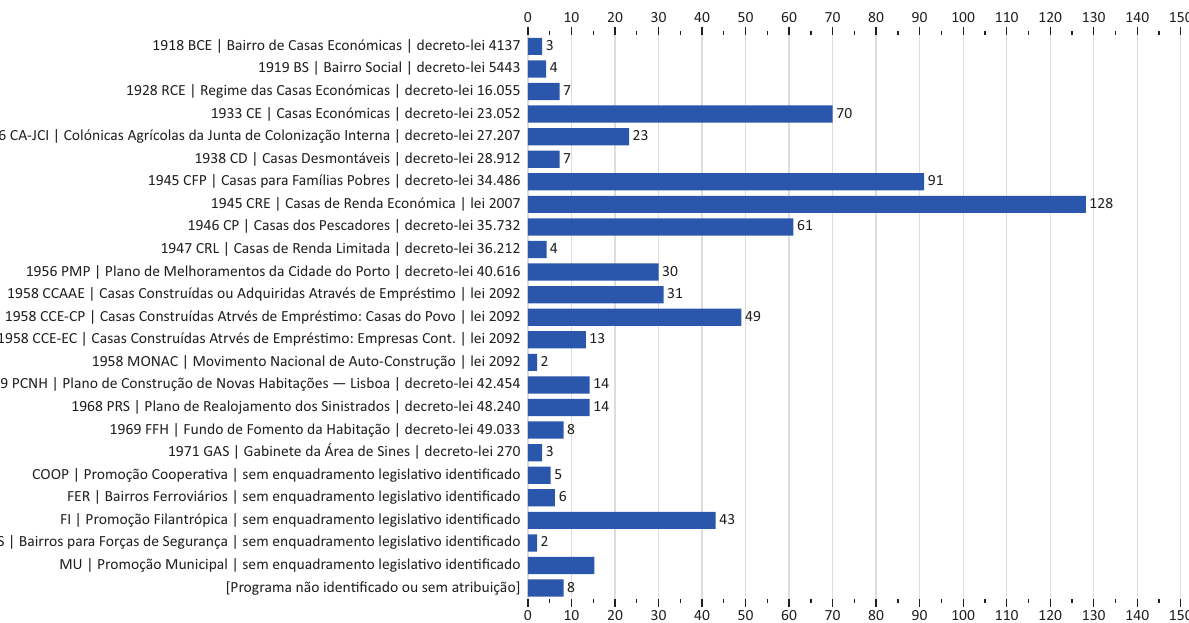
Figure 5. Linear chart with the number of built estates per housing programme. Note: The universe is composed of built estates and dwellings built between 1910 and 1974, included in the MdH database. Source: Ramos, Gonçalves, et al.